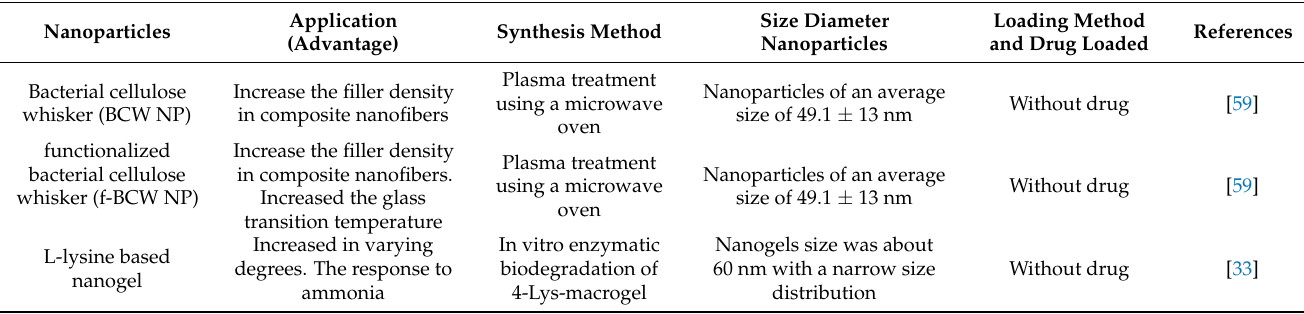
Table 1. Summary of the nanoparticles in hybrid systems. Applications, synthesis, size, and loading method